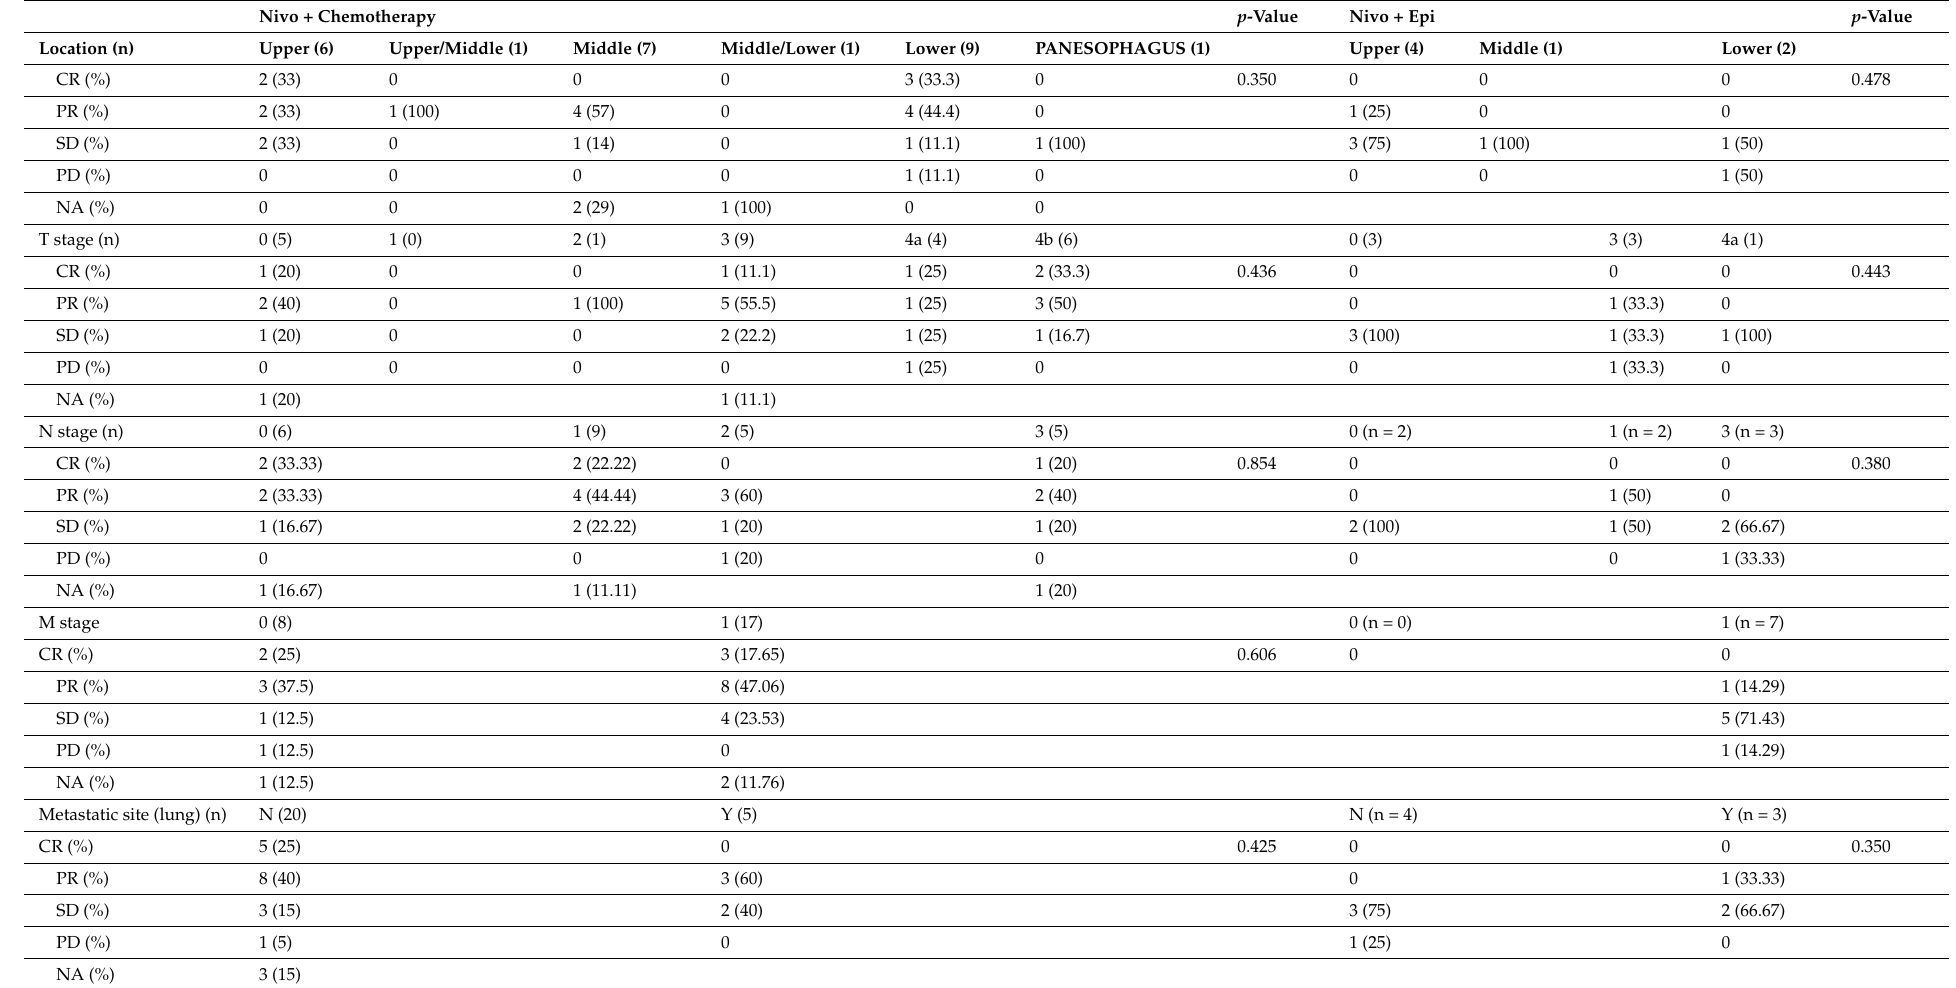
Table 2. Factors related to immune checkpoint inhibitor-containing regimen. I/O response related